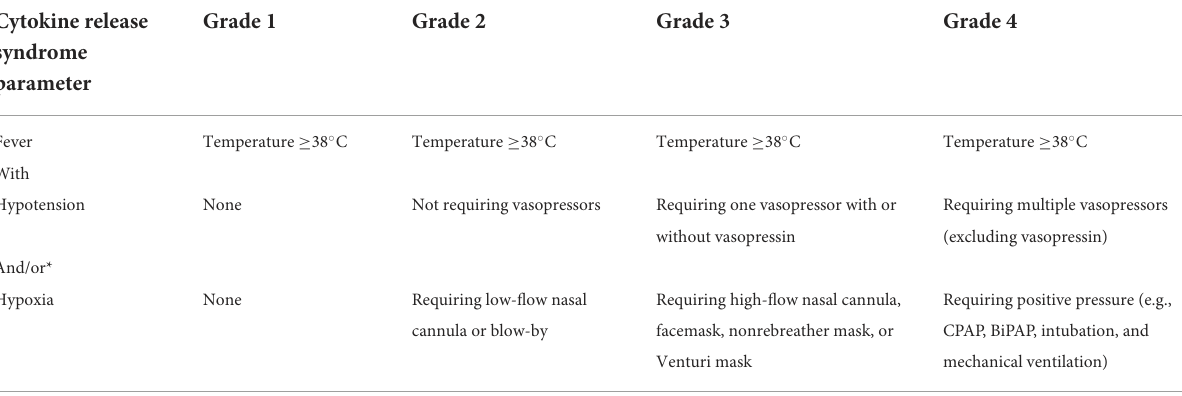
TABLE 3 American Society of Blood and Marrow Transplantation (ASBMT) consensus grading of cytokine release syndrome (CRS) severity (34).